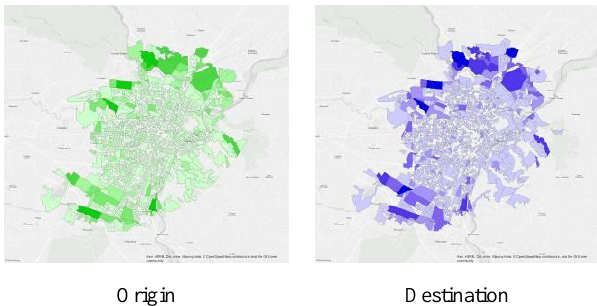
Figure 16. Census areas symbolised by number of paths generated (left) or ending (right) inside